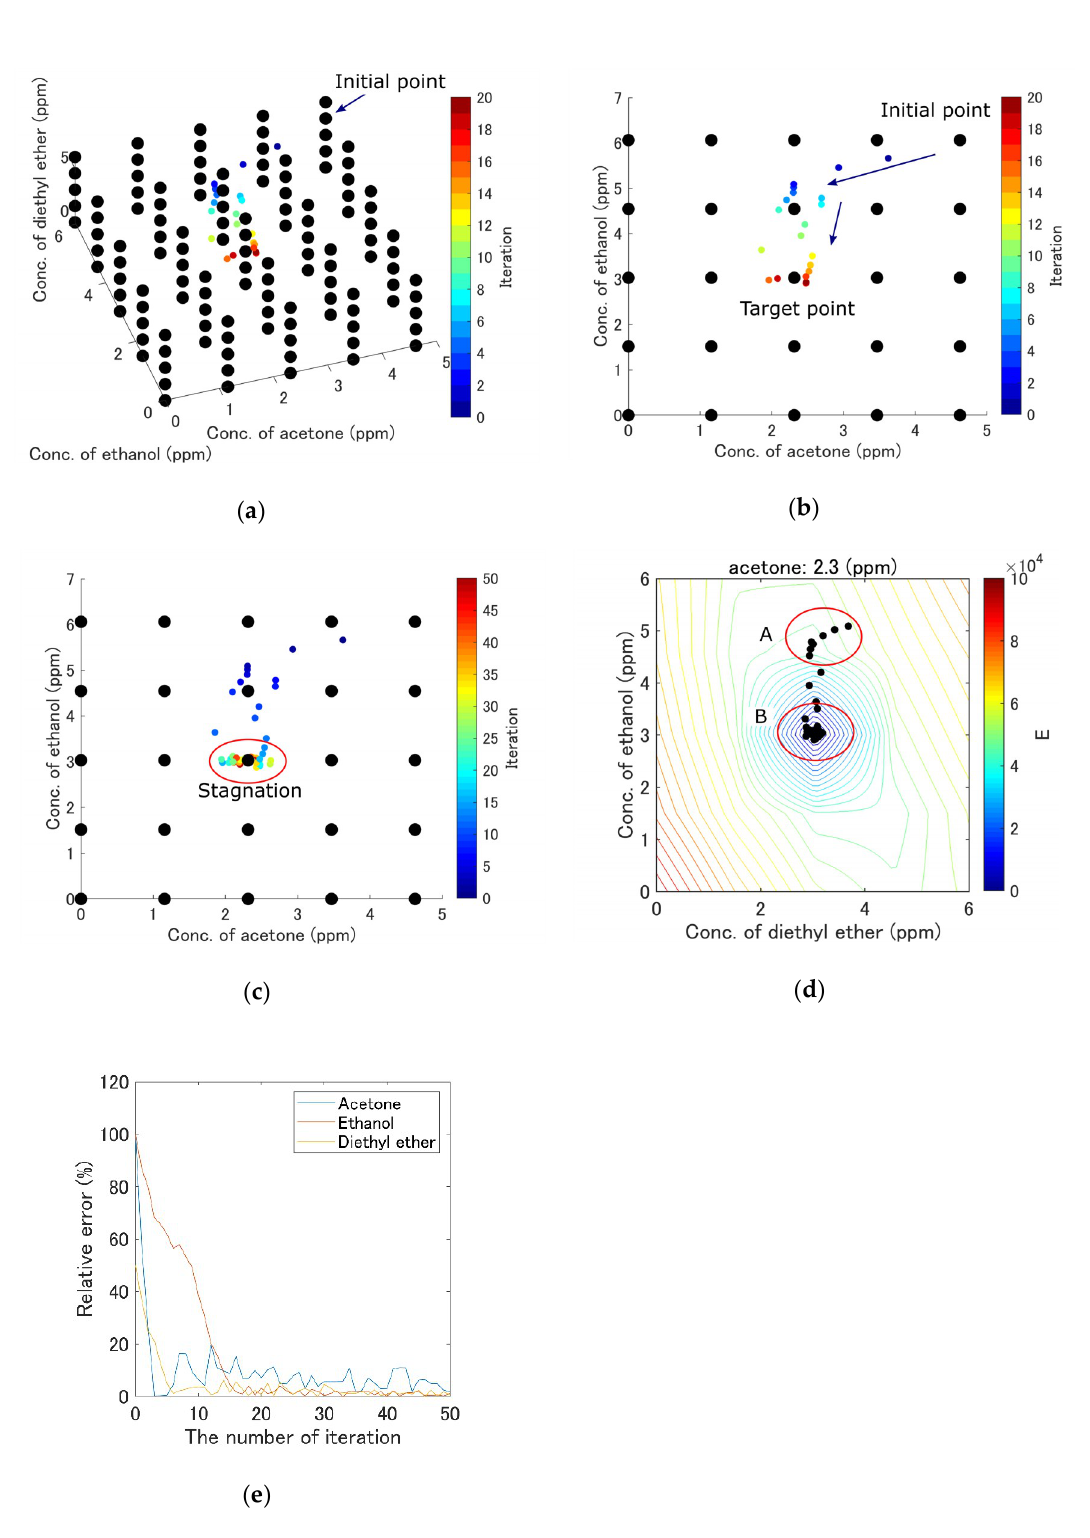
( d ) ( e ) Figure 8. The result of the determination of each gas concentration using the gradient descent method. The error hypersurface calculated from all measurement data was used for the gradient descent. The initial measurement points were acetone (4.6 ppm), ethanol (6.1 ppm), and diethyl ether (4.6 ppm). Acetone (2.3 ppm), ethanol (3.0 ppm), and diethyl ether (3.0 ppm) were selected for the target data.  was 1.0 × 10  . ( a ) 3D view. ( b ) Acetone–ethanol plane. ( c ) Acetone–diethyl ether plane. ( d ) Ethanol–diethyl ether plane. ( e ) The history of relative errors.